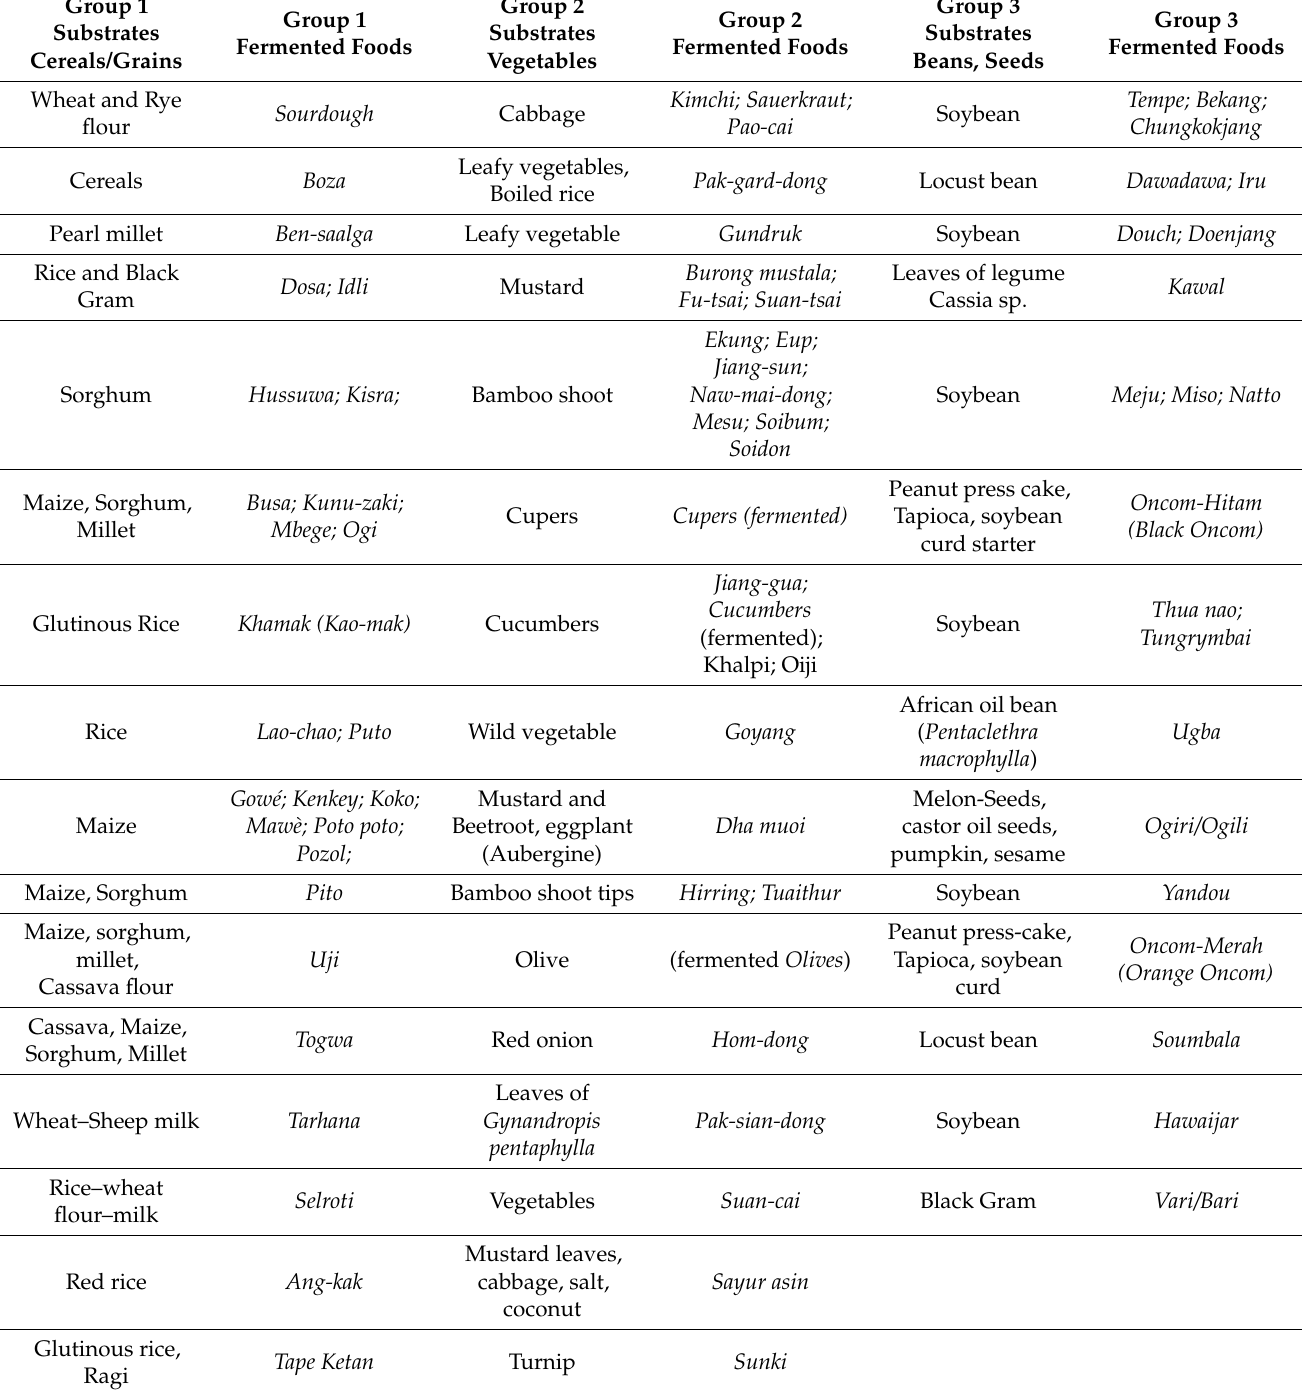
Table 3. Food products *, **, *** prepared from three main groups of plant-derived substrates (Source of information compiled in the table from references